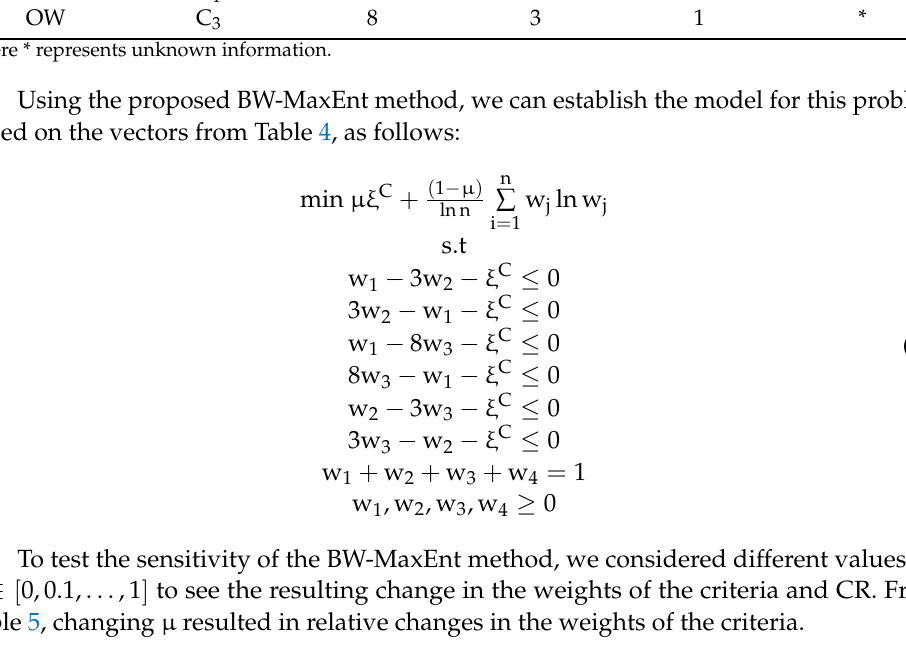
Table 5. Different values of w ∗